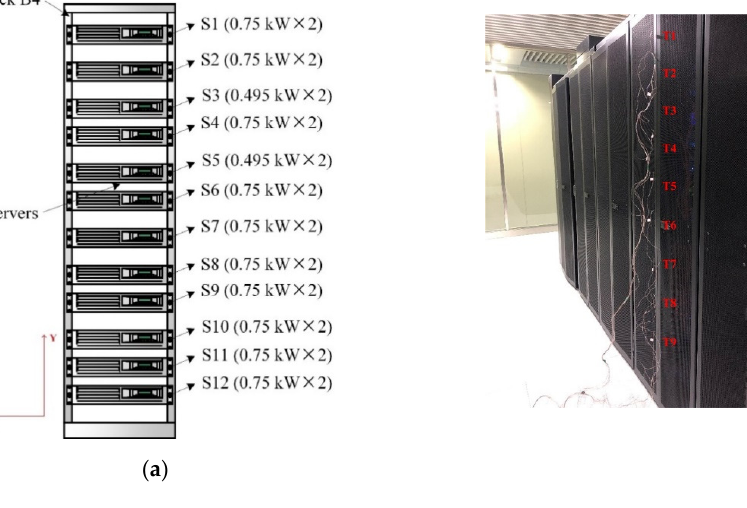
Figure 4. Schematic diagram of the server in the rack. ( a ) The layout and corresponding specifica- tions of the servers in rack B4. ( b ) Arrangement and test connection diagram of rack temperature test points.